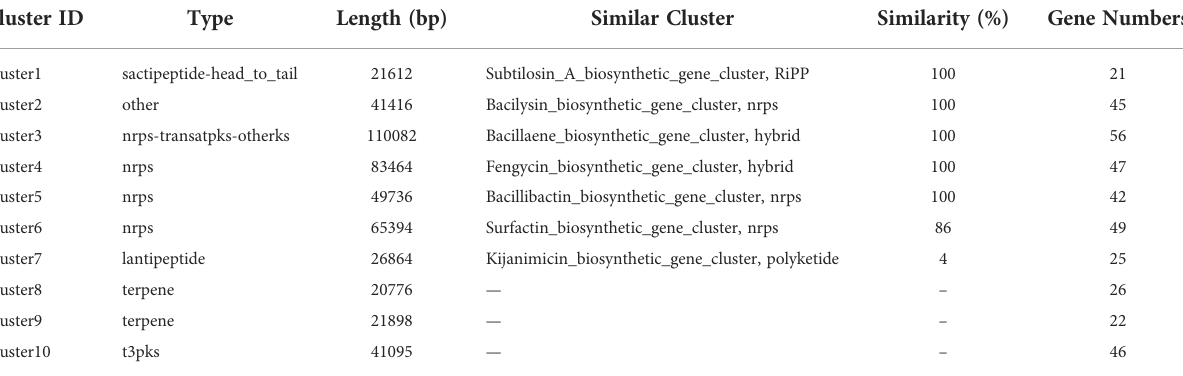
TABLE 2 Biosynthetic gene clusters for secondary metabolites in the genome of B. halotolerans